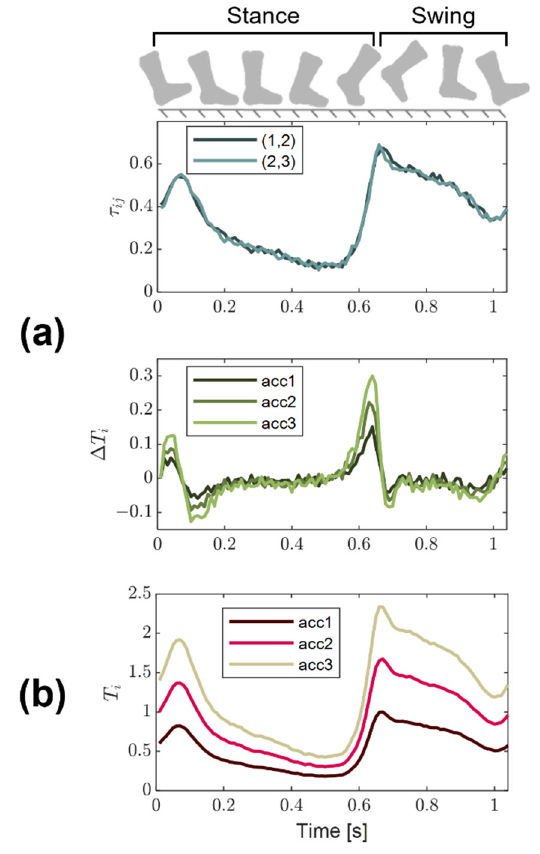
Figure 2. ( a ) An example of the Kalman filter measurements, inputs, and outputs for a tensiometer with 3 accelerometers. The wave travel time ( τ ij ) between successive pairs of equally spaced accelerometers was generally similar, with slight differences due to noise in the system. The change in wave arrival ( ∆ T i ) at an accelerometer between tap events was centered around zero, with larger changes in arrival for accelerometers further from the tapper. ( b ) The estimated arrival time of the wave at each accelerometer ( T i ) as computed by the Kalman